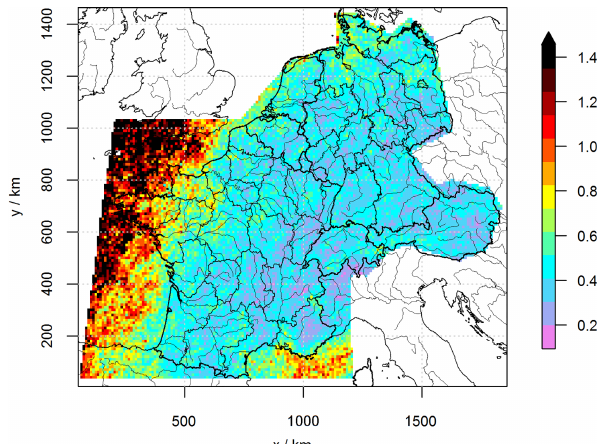
Figure 10. Dispersion of the annual number of thunderstorm days measured by the coefficient of